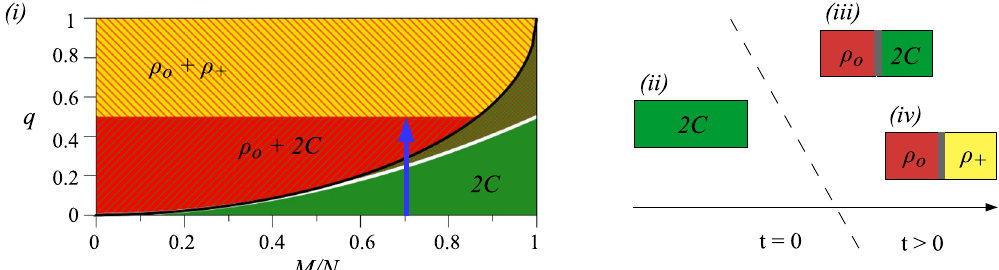
Figure 1. (i) The phase diagram of antiferromagnetic BECs 41,45 in the thermodynamic limit (when the (cid:31) / √ 2 m c L ) and spin healing length ξ s 2 ρ is much smaller than the linear system size L , i.e., ξ s ≪ = positive magnetization. Three homogeneous phases (marked by colors) can be revealed: 2C phase (green) 1 coexist; ρ 0 (red) and ρ in which the components m F (yellow) phases in which atoms occupy the = ± + 0 and m 1 Zeeman state, respectively. The ground state of the system is (ii) the 2 C phase when m F F = + = ( M / N ) 2 / 2 (solid white line), (iii) the phase separated into 2 C and ρ 0 domains for q ( q 1 , q 2 ) ,and q < q 1 = ∈ q 2 . Here q 2 is a ’contractual’ crossover between the (iv) the phase separated into ρ and ρ 0 domains when q ≫ + 2 C and ρ 1 / 2 was derived in the thermodynamic limit omitting any ρ 0 phases. In 45 the value of q 2 ρ 0 + = + + excitation. In fact, q 2 depends on the system size and, e.g., thermal excitation as was pointed out in the recent 1 1 ( M / N ) 2 (solid experimental work 41 . The 2C phase remains a local energy minimum up to q c = − − 2 C are black line) 46 . The region between the white and black solid lines is where the two phases 2 C and ρ 0 (cid:31) + stable. The vertical thick lines in (iii) and (iv) illustrate domain walls. The blue arrow in (i) shows an example of 0.5 0.7 and q the considered quench for M / N = =